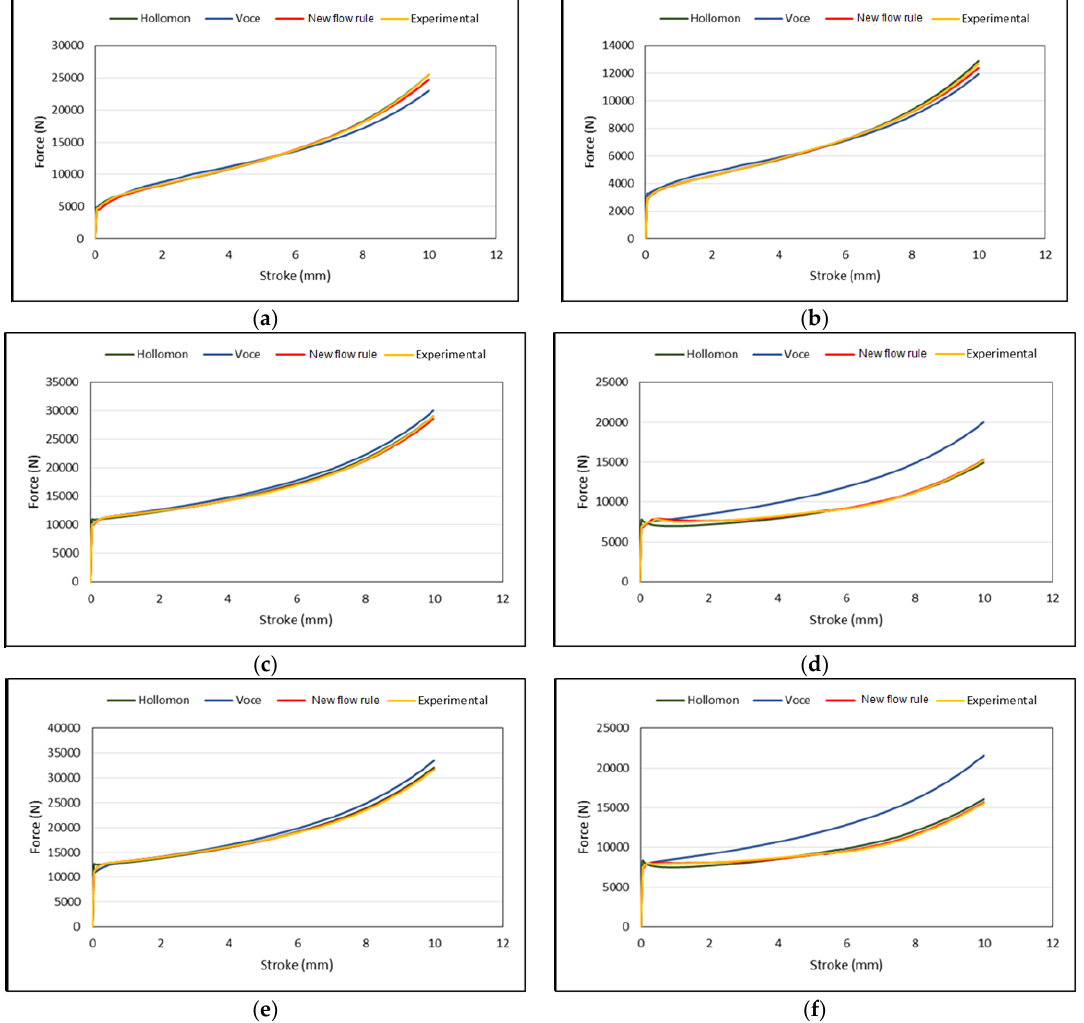
Figure 15. Load-stroke curves obtained by FEM for AA3103 at the three starting states: ( a ) AA3103 N0 25 °C; ( b ) AA3103 N0 250 °C; ( c ) AA3103 N2 25 °C; ( d ) AA3103 N2 250 °C; ( e ) AA3103 N4 25 °C; ( f ) AA3103 N4 250 °C.